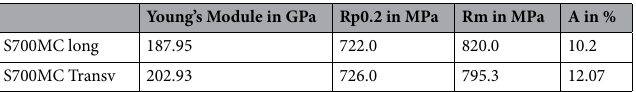
Table 2. Mechanical properties of the tested material 26 .